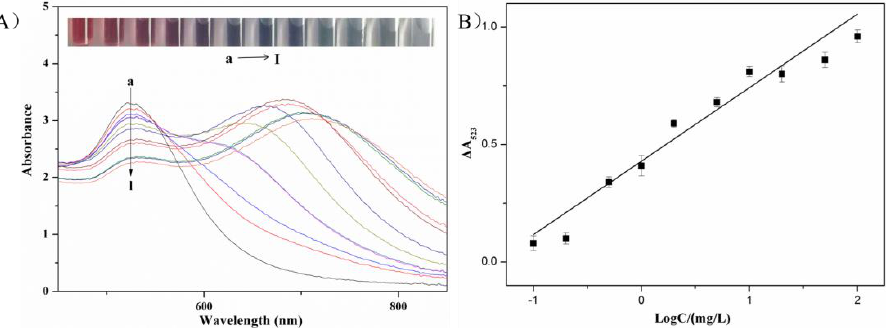
Figure 6. ( A ) (a → l) UV-Vis spectra of AuNP solutions, AuNP solutions with concentrations of metsulfuron-methyl of 100 mg/L, 50 mg/L, 20 mg/L, 10 mg/L, 5.0 mg/L, 2.0 mg/L, 1.0 mg/L, 0.5 mg/L,